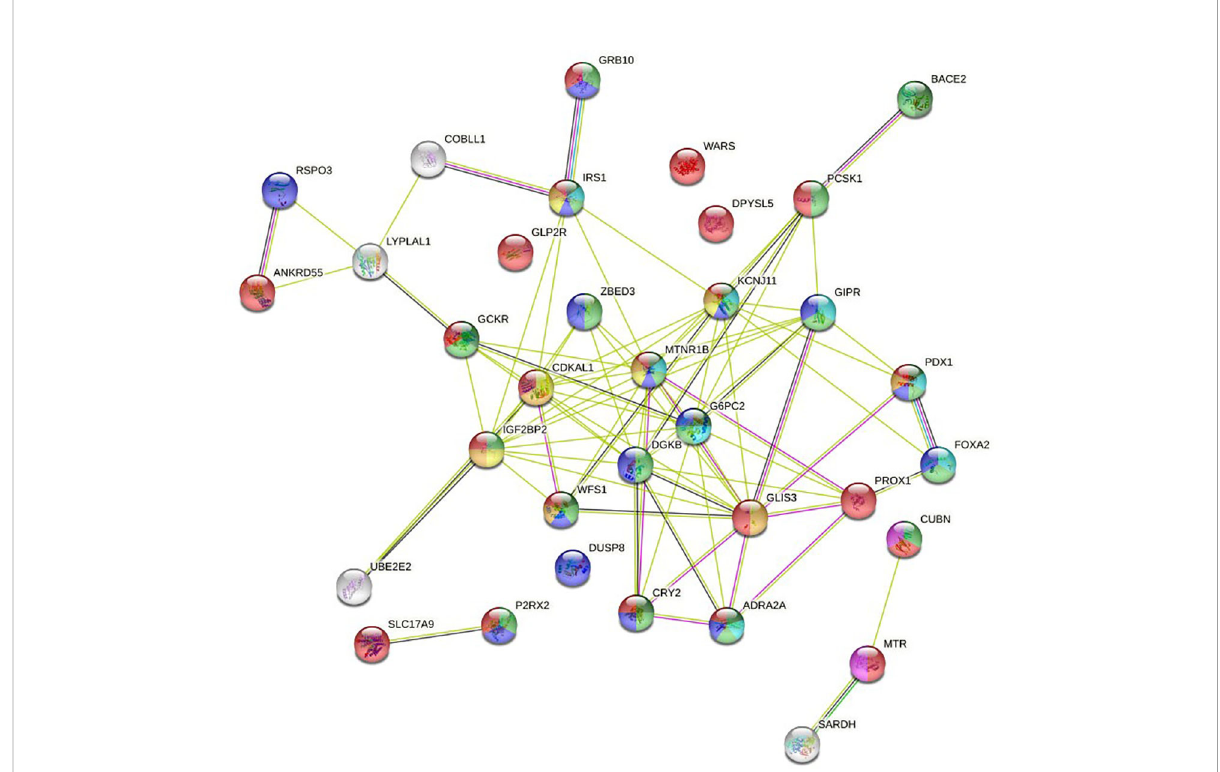
FIGURE 2 Full STRING network of both functional and physical protein associations. The edges indicate both functional and physical protein